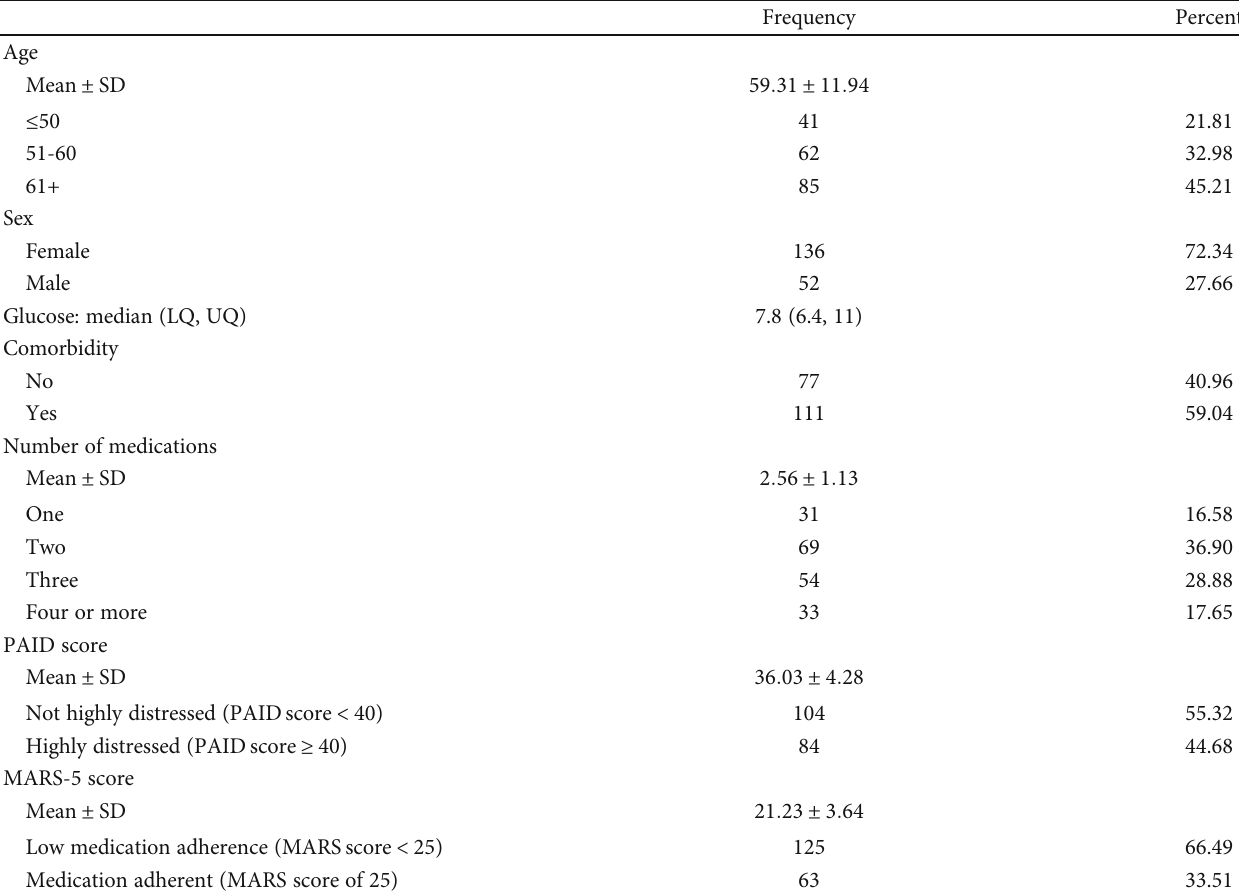
Table 1: Background and clinical characteristics of patients with T2DM receiving treatment at Pantang